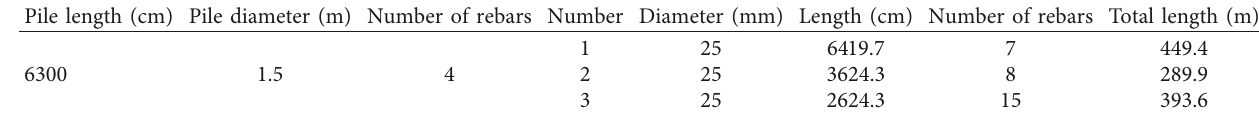
Figure 20: (a) Placement of the steel casing. (b) Equivalent steel ring. Table 7: Reinforcement parameters of the FY3#-0 CCFSTP.